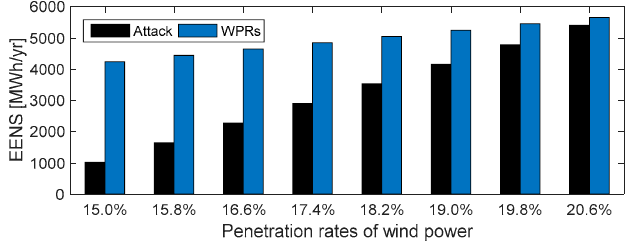
Figure 9. EENS caused by cyber-attacks and WPRs.